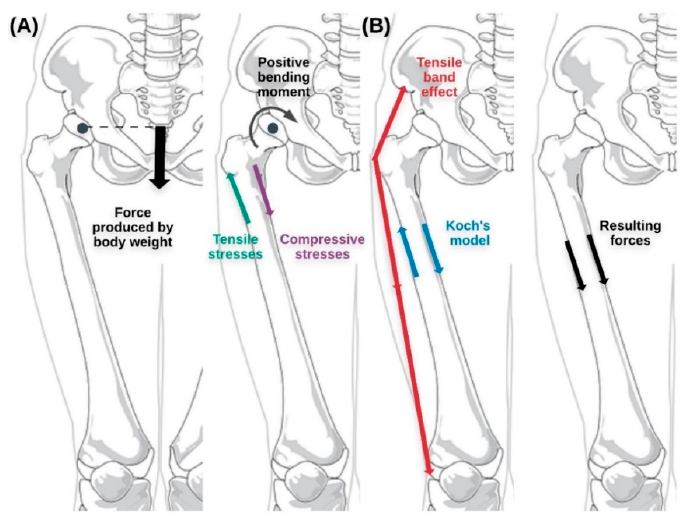
Figure 1. Comparison between: ( A ) Koch’s model that takes into account only the BW effect, and ( B ) considering the forces that are generated by iliotibial band and the vastus lateralis–gluteus medius complex.